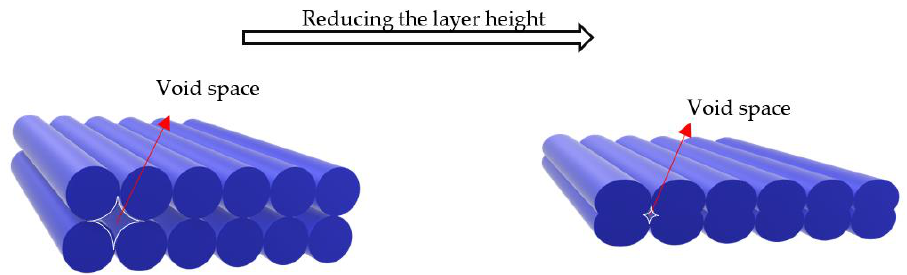
Figure 13. Change in the porosity and cross-sectional shape of void spaces by changing the layer height.